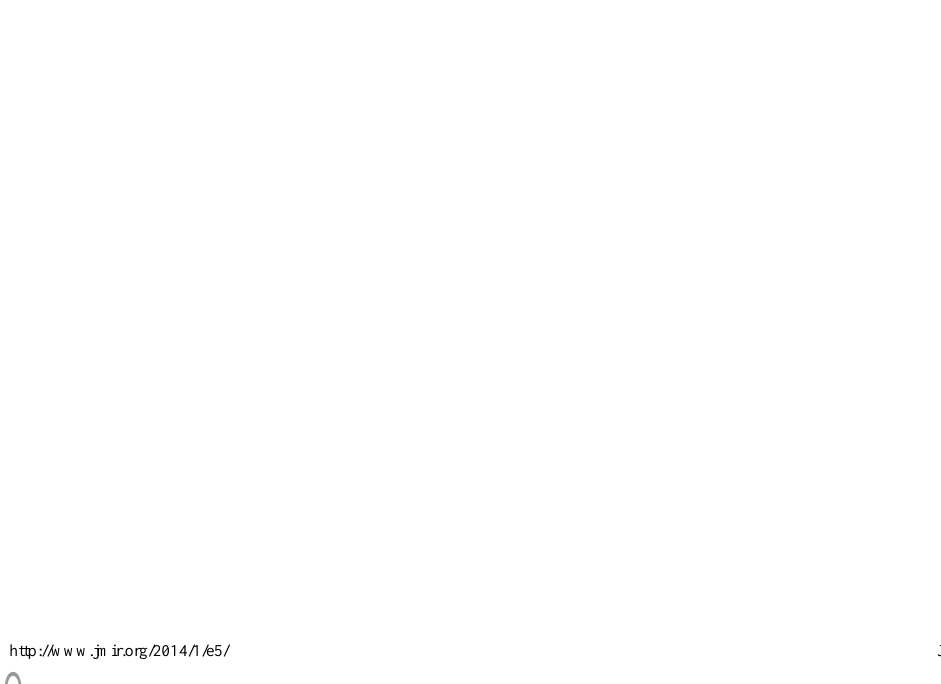
P Unstandardized estimate (SE)